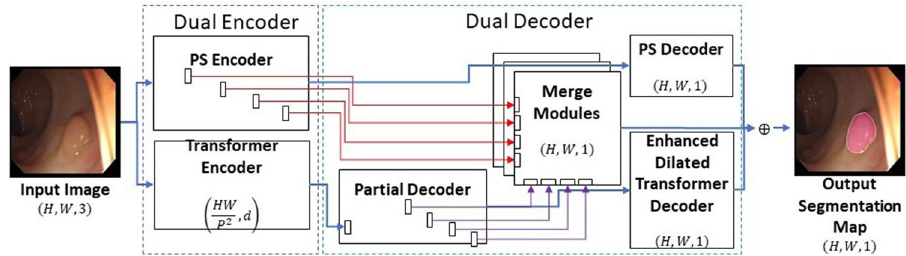
Figure 1. Overall schematic view of our proposed PSNet.